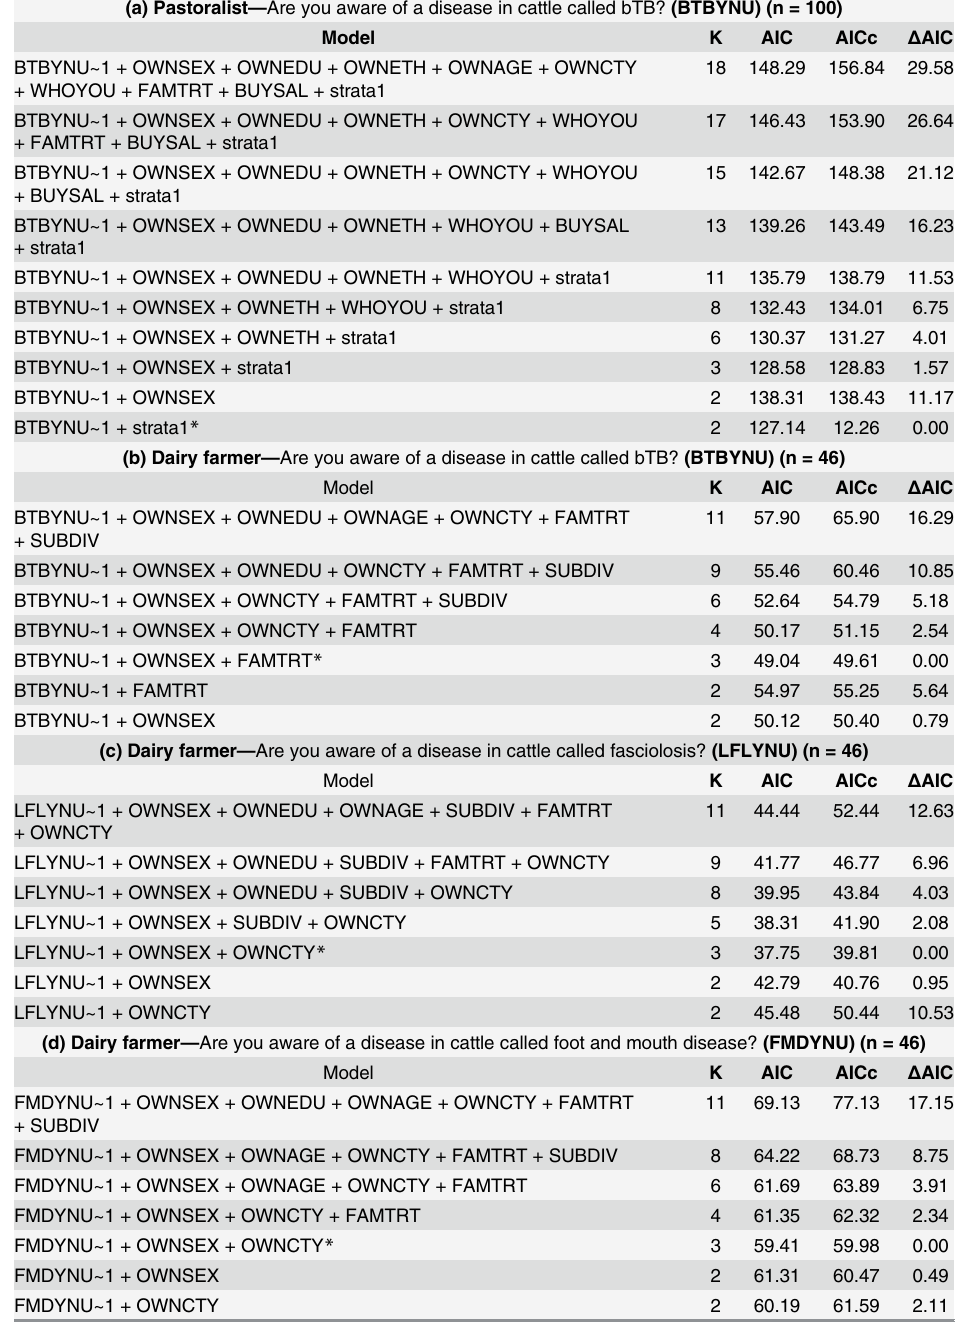
Table 2. Comparison of mixed-effects logistic regression risk factor models for disease awareness. (a) “ Are you aware of a disease in cattle called bTB? ” (BTBYNU) in pastoralists (n = 100), (b) “ Are you aware of a disease in cattle called bTB? ” (BTBYNU) in dairy farmers (n = 46), (c) “ Are you aware of a disease in cat- tle called fasciolosis? ” (LFLYNU) in dairy farmers (n = 46,) and (d) “ Are you aware of a disease in cattle called foot and mouth disease? ” (FMDYNU) in dairy farmers (n = 46). Explanatory variables included are OWNSEX (Gender), OWNEDU (Education level), OWNETH (Ethnic group), OWNAGE (Age), OWNCTY (Years worked with cattle), WHOYOU (Job title for pastoralist only), FAMTRT (Do you treat milk?), BUYSAL (Do you trade cattle? For pastoralist only), strata1 (Pastoralist study site) and SUBDIV (Dairy farmer cooperative group). Selected model =